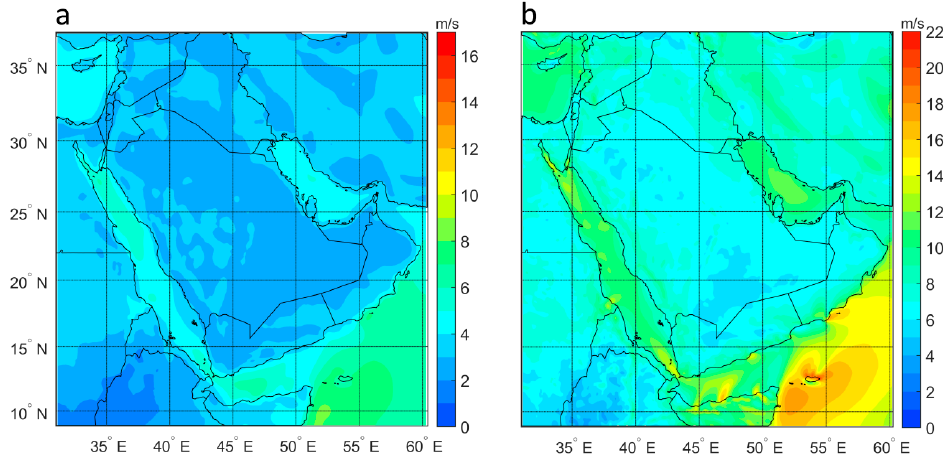
Figure 12. Annual distribution of ( a ) mean wind speed and ( b ) wind speed of the 95th percentile at 10 m.